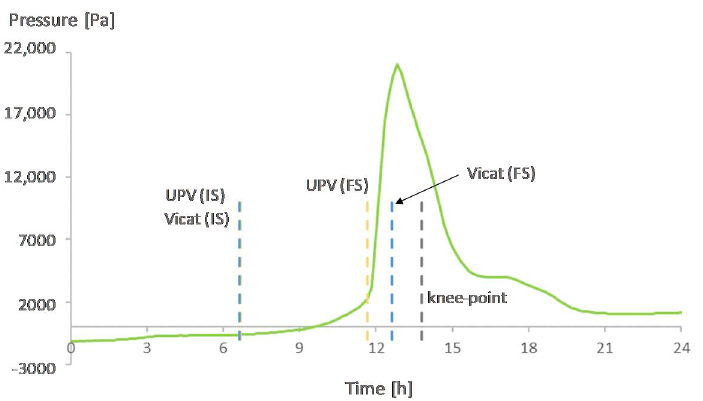
Figure 8. Capillary pressure, setting times, and transition point of SAP1. With IS referring to initial setting and FS referring to final